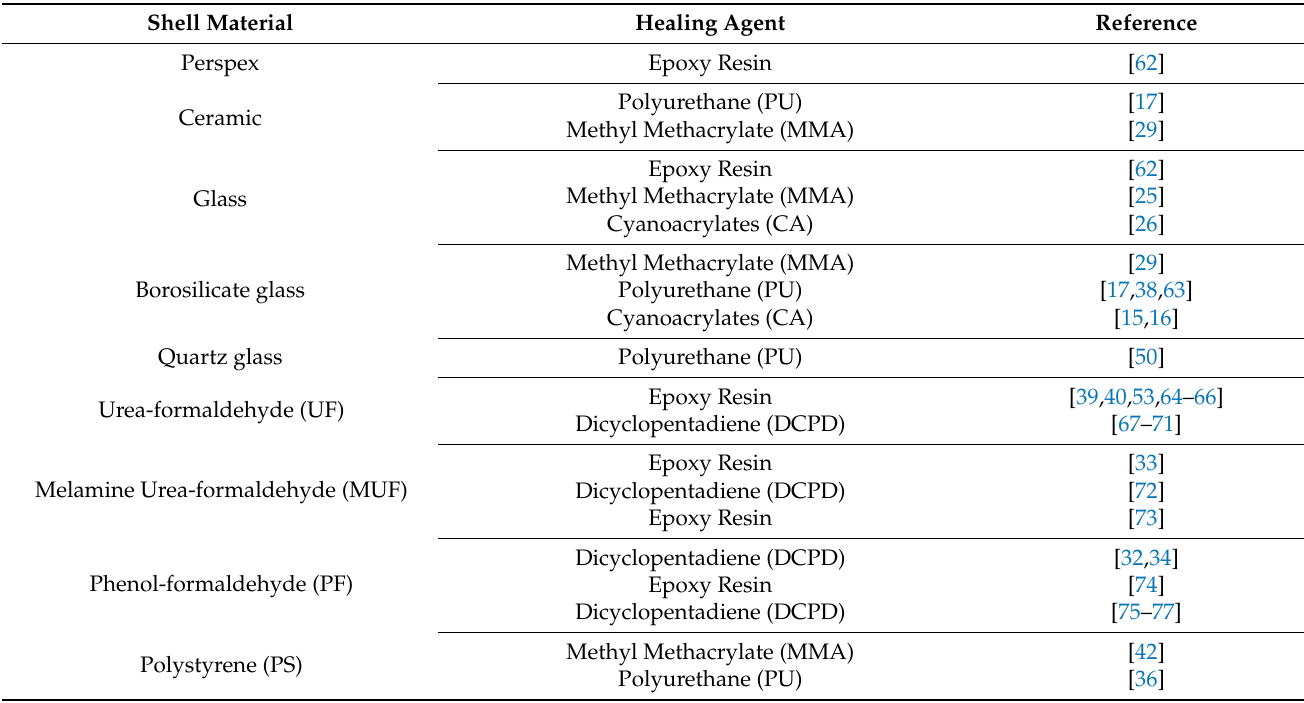
Table 1. Common shell materials and healing agents used in self-healing